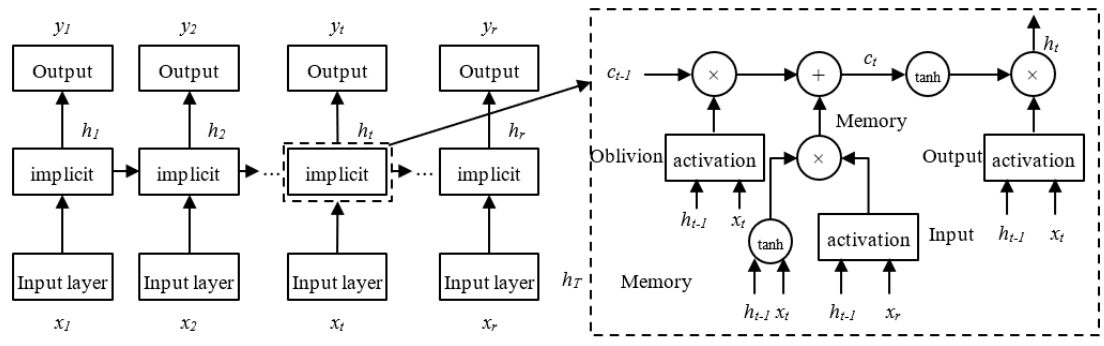
Figure 1. LSTM structure diagram.